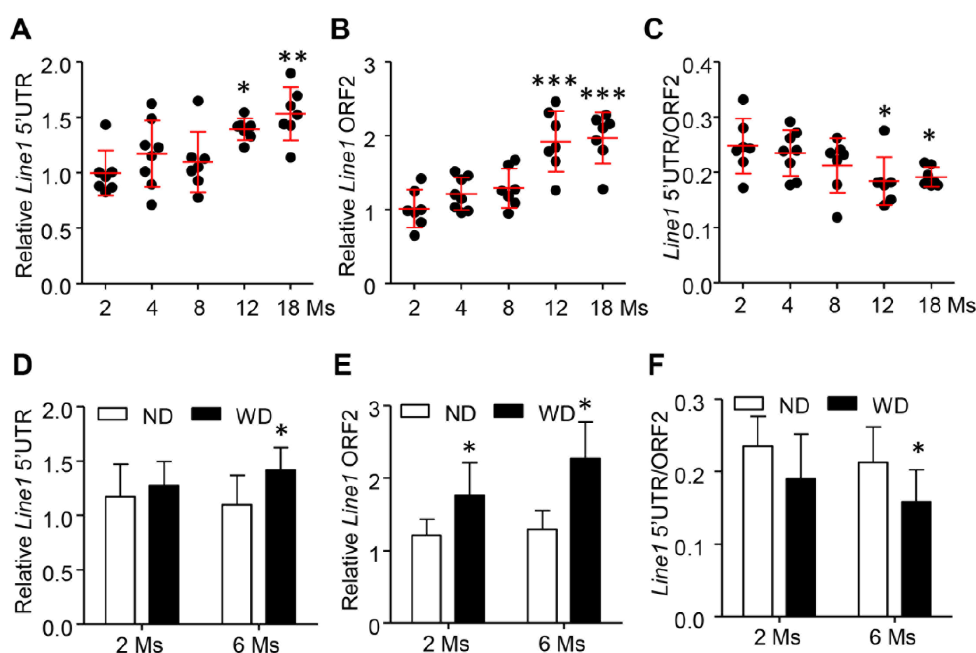
Figure 3. Release and cleavage of cfDNA were increased during the development of AS in ApoE −/− mice. ( A , B ), The cfDNA concentration of long fragment ( Line1 5′ UTR) ( A ) and short fragment ( Line1 ORF2) ( B ) in the serum of ApoE −/− mice at different stages. ( C ) Levels of cfDI ( Line1 5′UTR/ Line1 ORF2) during the development of ApoE −/− mice. ( D , E ) The concentration of long fragment ( D ) and short fragment ( E ) of cfDNA between ApoE −/− mice fed with 6 months of western diet (WD) and normal diet (ND). ( F ) Levels of cfDI in ApoE −/− mice fed with WD and ND. Data are shown as mean ± SEM and were evaluated by unpaired t test. * p < 0.05, ** p < 0.01, *** p < 0.001.